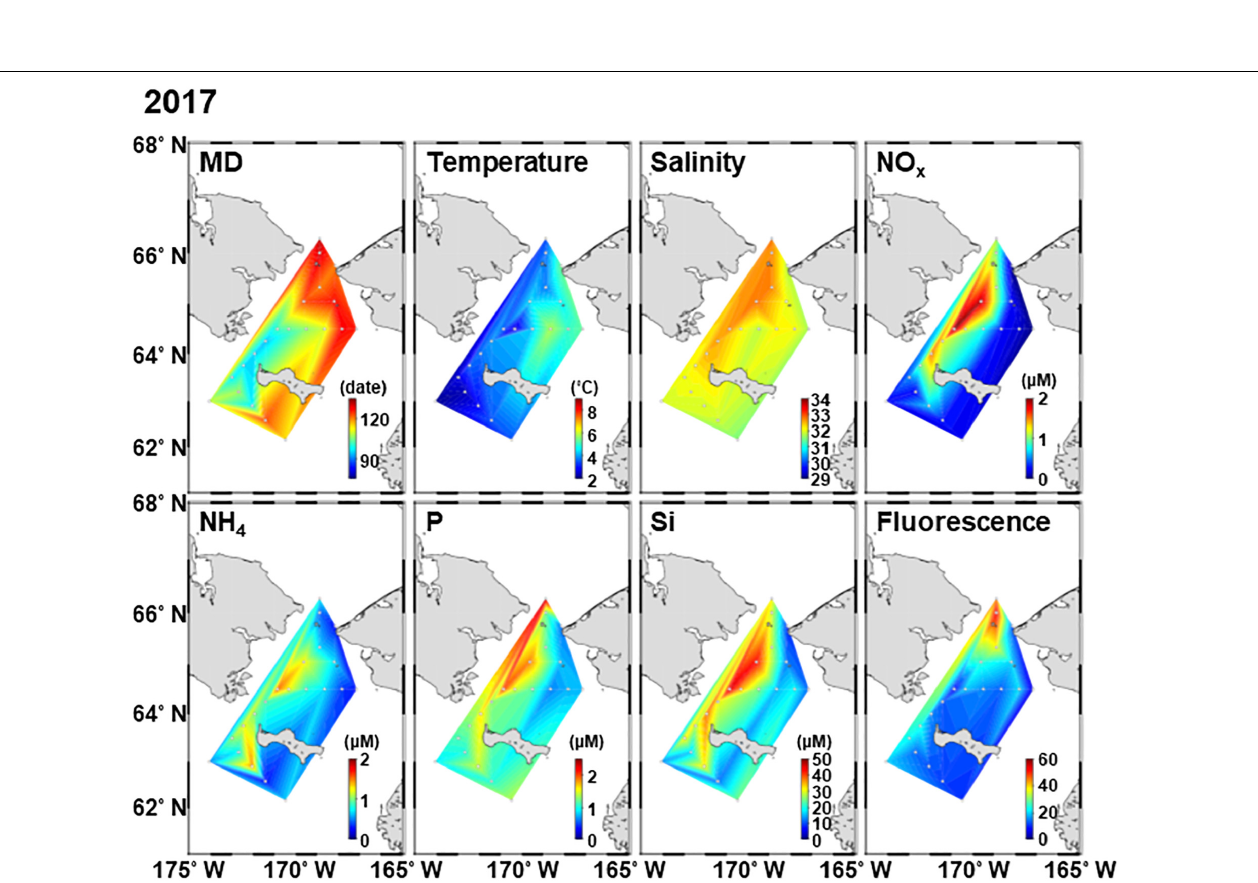
FIGURE 2 | Horizontal distribution of environmental factors in the northern Bering Sea during 11–22 July 2017. MD, melt day.